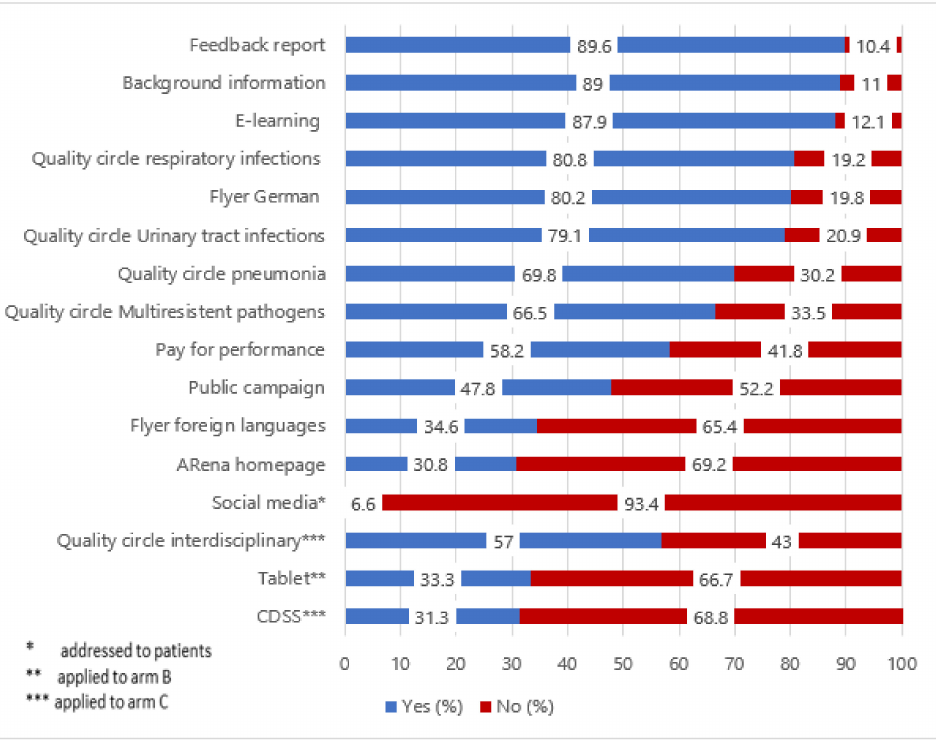
Figure 1. Uptake of intervention components (T2, n =